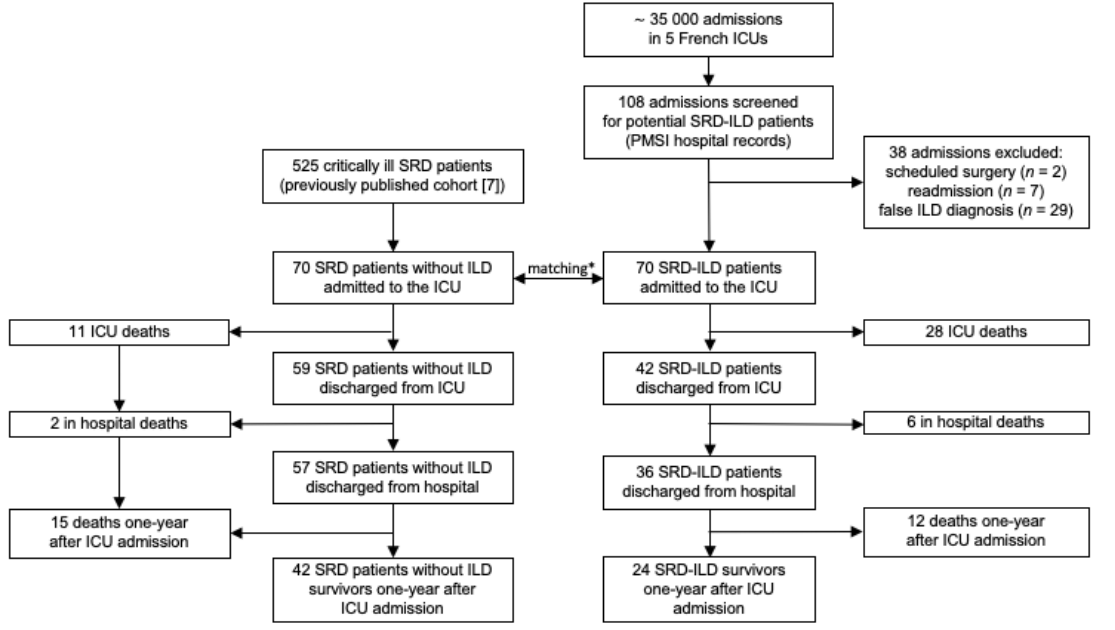
Figure 1. Flow chart of the study population. ICU = intensive care unit, ILD = interstitial lung disease, PMSI = Programme de Medicalisation des Systemes d’Information, SRD = systemic rheumatic diseases. * Control group of critically ill SRD patients without ILD matched on the basis of age, sex, Charlson index, SOFA score, SRD type, and/or level of immuno- suppression. Table 1. SRD-ILD patients’ characteristics.